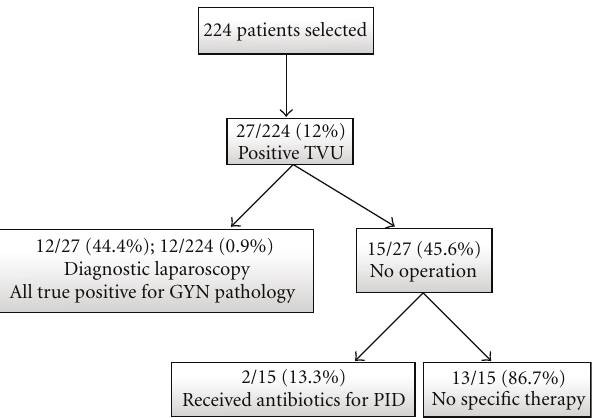
Figure 3: Patients with positive transvaginal ultrasound (TVU).